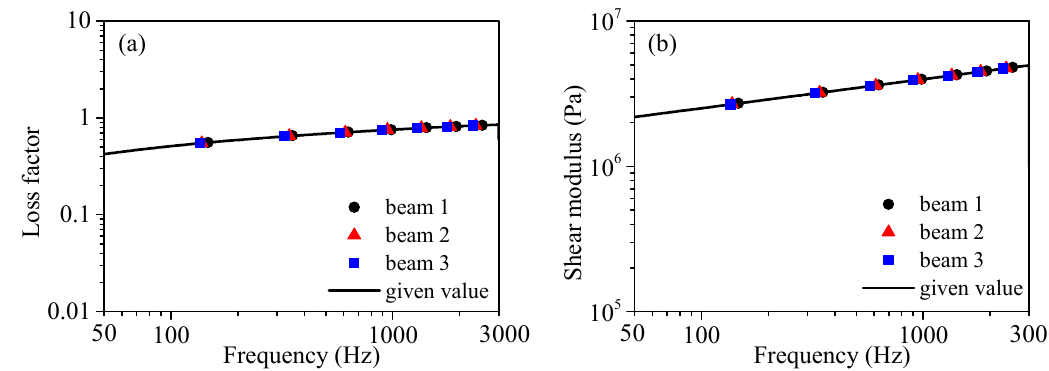
Figure 4. Simulation results of frequency-dependent loss factor and shear modulus by three sandwich beams: ( a ) modal loss factors and ( b ) modal shear moduli.